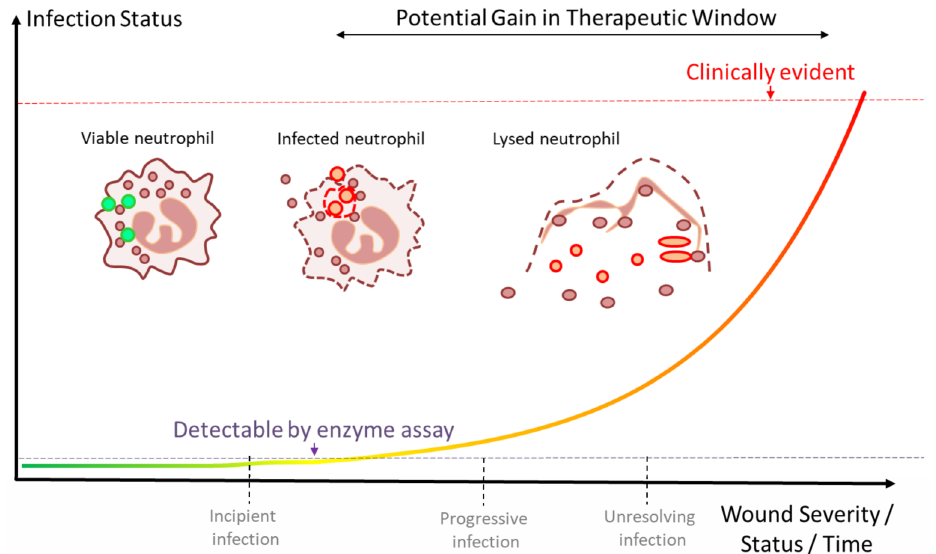
Figure 6. Time course of wound infection. On the X-axis, the stage of infection, as determined from visible signs, is shown with progressively worsening infection severity to the right. The quantity and activity of detectable markers are shown on the Y-axis, with more markers being released as infection status worsens and more immune cells are recruited. Two levels are indicated — the level at which infection is visible to the eye through edema, redness and suppuration (red dotted line) and the level at which these markers can be detected by appropriate assays and potentially, POC tests (purple dotted line).